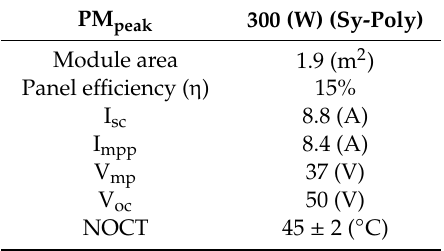
Table 1. Main characteristics of photovoltaic (PV) panels.